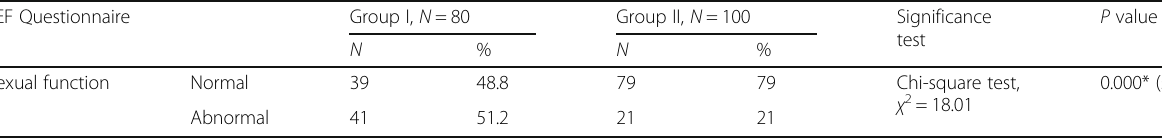
Table 2 Sexual dysfunctions among patients of group I and group